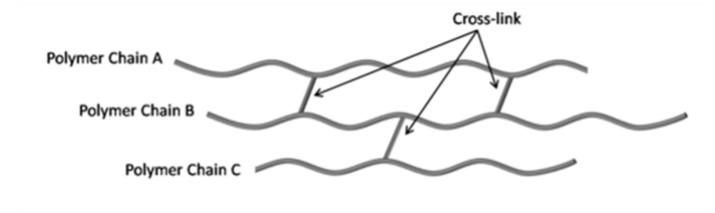
Fig. 7 Cross-linking